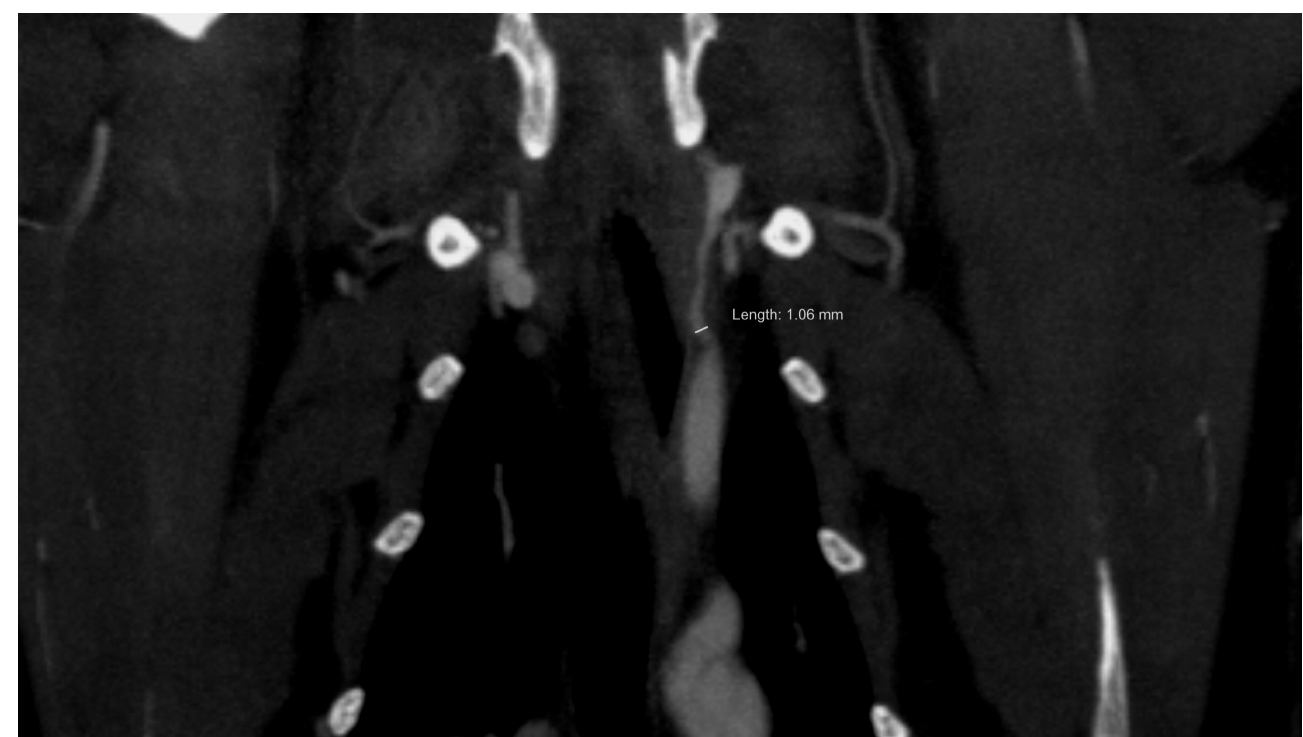
Figure 6. Skeletonization and linear representation of the tract in which the tool has identified the stenosis.